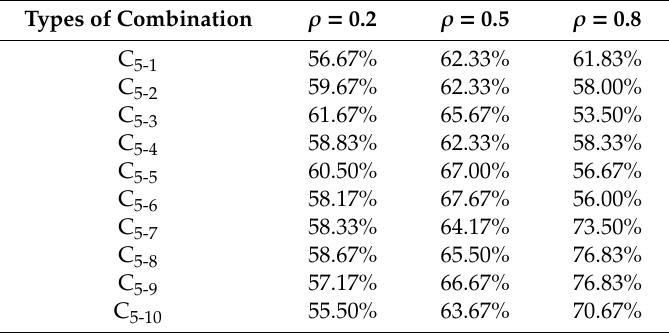
Table 8. Multivariate adaptive regression splines (MARS) identification results, AIR -MARS {null}, for ten combinations of faults of an MNP 5.